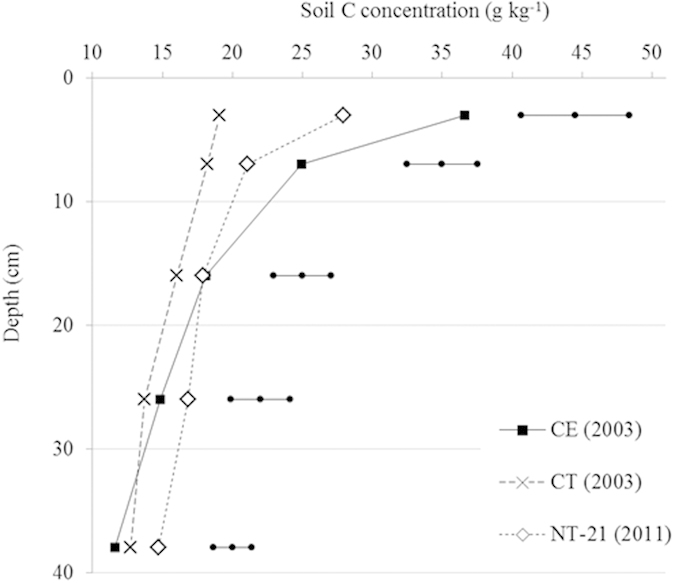
Soil carbon contents as function of soil depth under CE (native Cerrado, 2003 sampling), CT (conventional tillage cropping system, 25 years old, 2003 sampling) and NT-21 (no-tillage cropping system, 21 years old, 2011 sampling).Horizontal lines show the Tukey’s 95% confidence intervals.